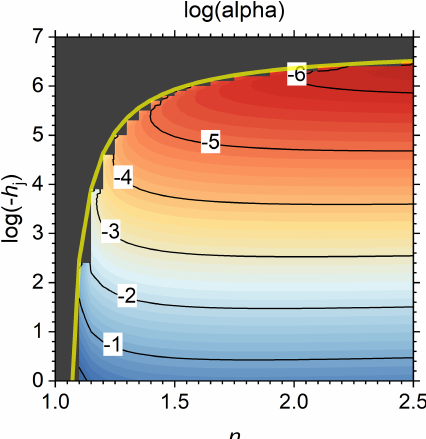
Figure 1. The logarithm of shape factor α (cm − 1 ) as a function of shape factor n and the matric potential at the junction point h j (cm H 2 O) according to Eq. (3), with h d fixed at − 10 6 . 8 cm. The labels of the contour lines represent log( α) . The transparent yellow curve is the limit of the valid domain according to Eq. (4). The black area is the invalid part of the